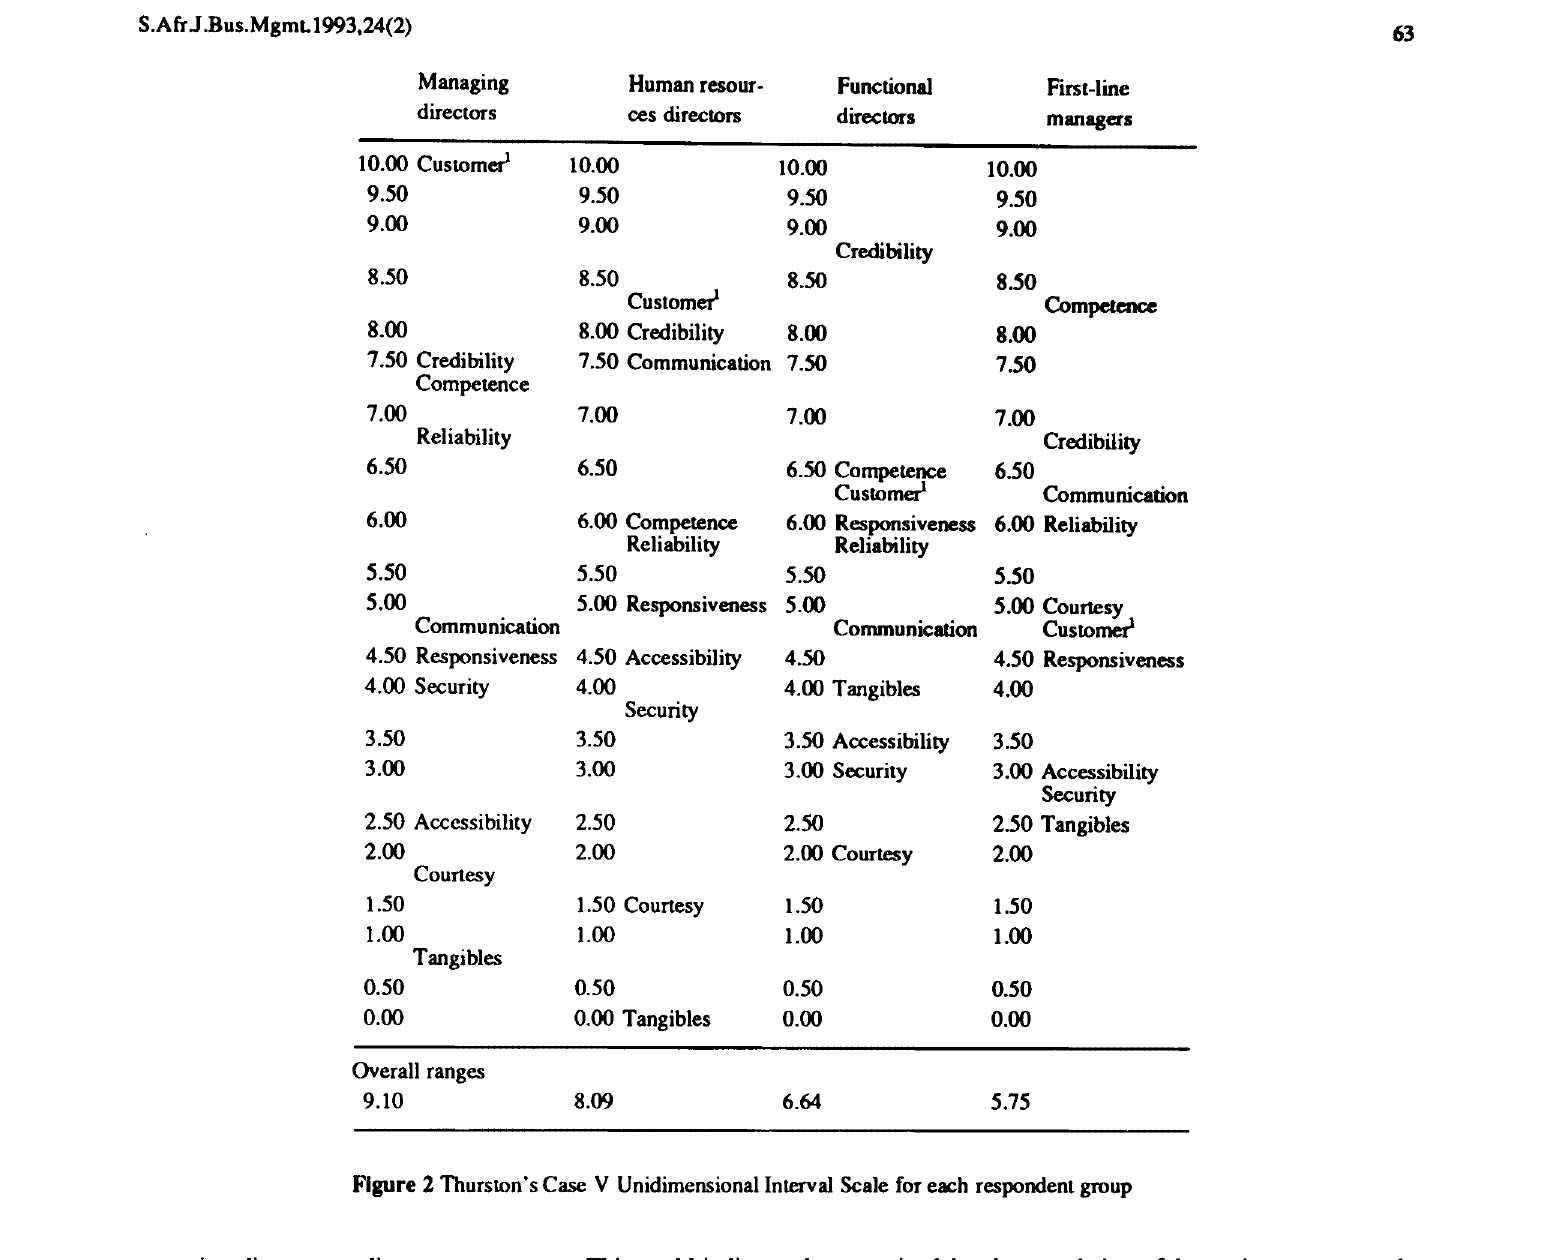
Figure 2 Thurston's Case V Unidimensional Interval Scale for each respondent